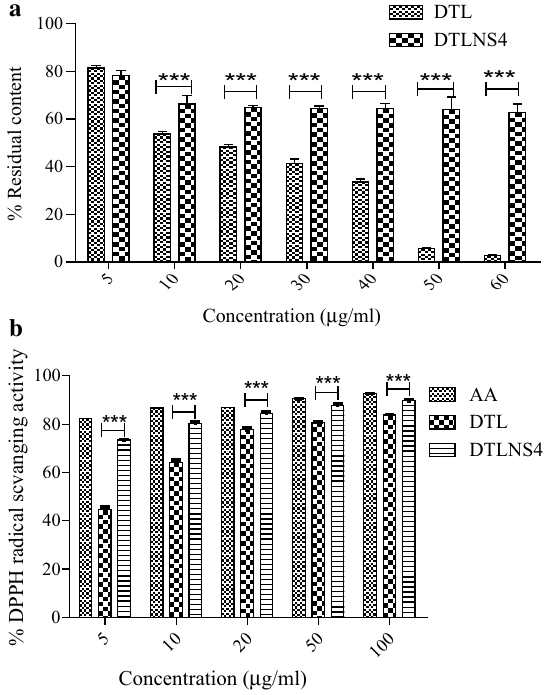
Fig. 10 a Residual content (%) of dithranol (DTL) and dithranol-loaded nanosponges (DTLNS4) after photodegradation study. All data are expressed as mean Data were analyzed by two-way ANOVA, followed by Bonferroni’s posttest (***). Statistically significant difference (*** p < 0.001). b 2,2-Diphenyl-1-picryl-hydrazyl-hydrate radical scavenging activity of ascorbic acid (AA), dithranol (DTL) and dithranol-loaded nanosponges (DTLNS4). All data are expressed as mean Data were analyzed by two-way ANOVA, followed by Bonferroni’s posttest (***). Statistically significant difference (*** p <